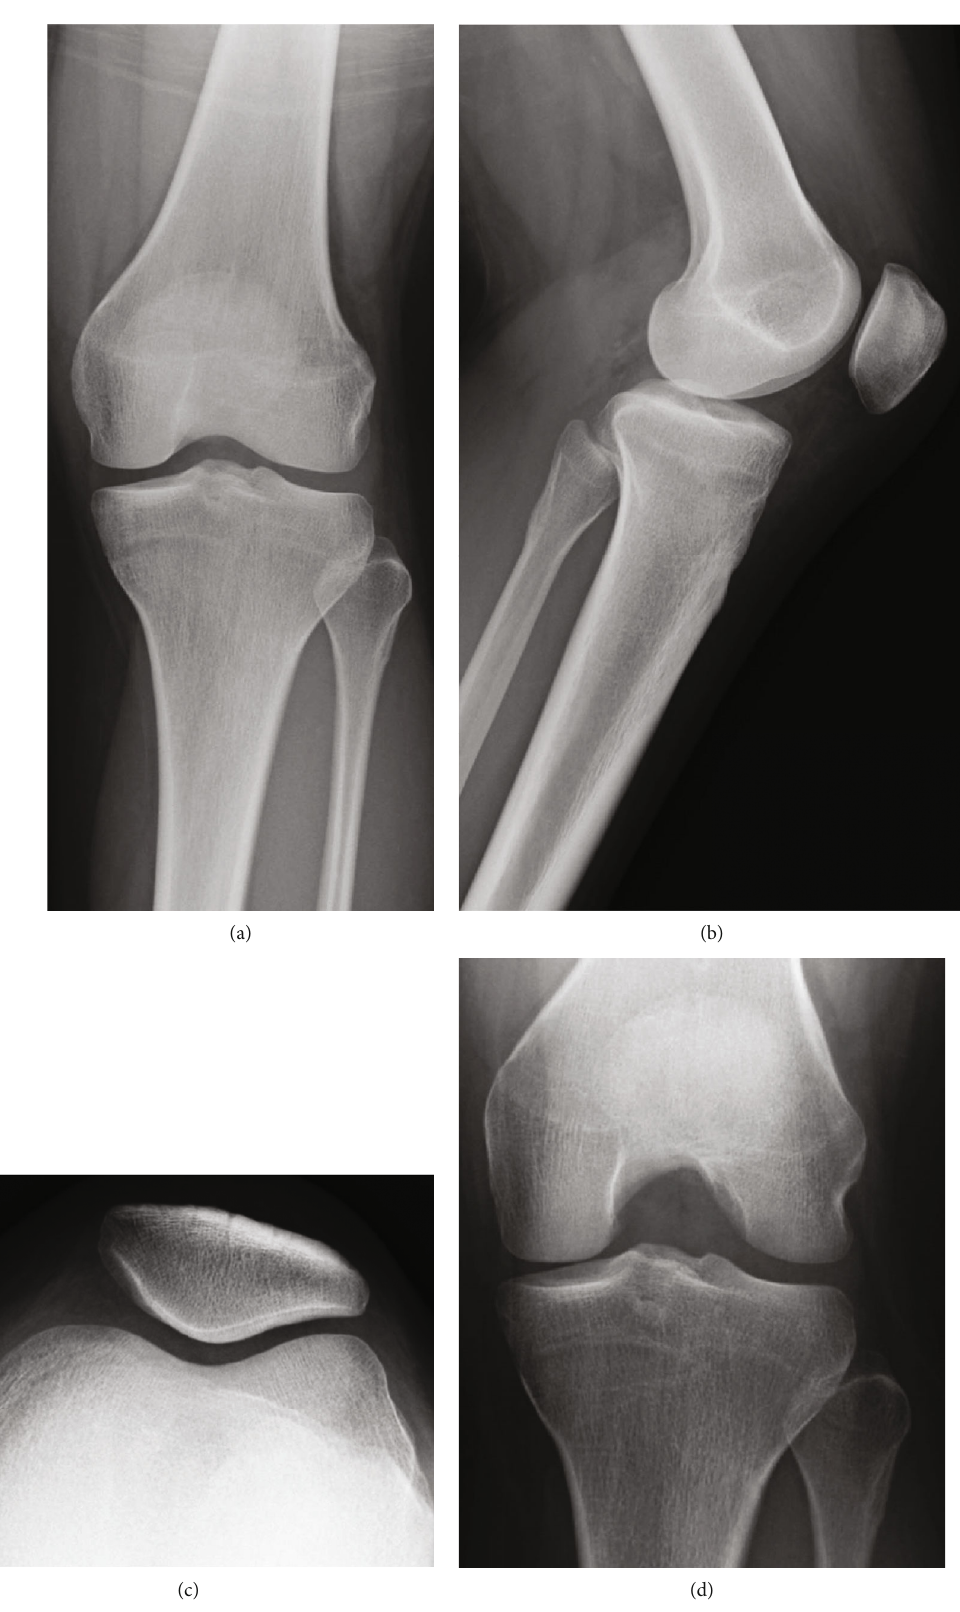
Figure 1: Preoperative radiography. The preoperative radiography was normal. (a) Anteroposterior view; (b) lateral view; (c) skyline view; (d) Rosenberg